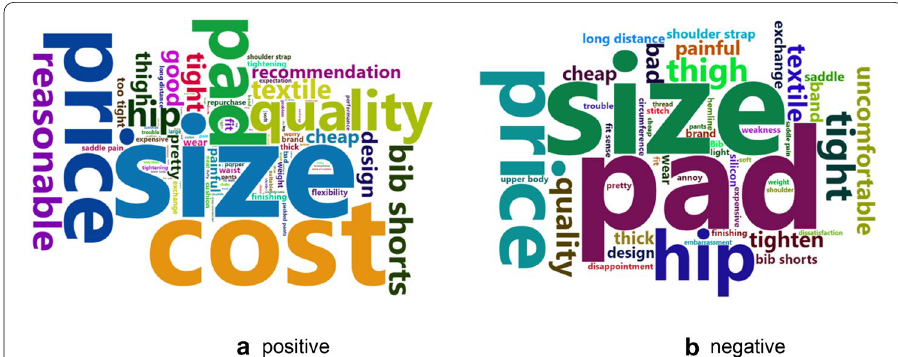
Fig. 5 Word clouds of reviews on cycling pants from 2017 to 2020